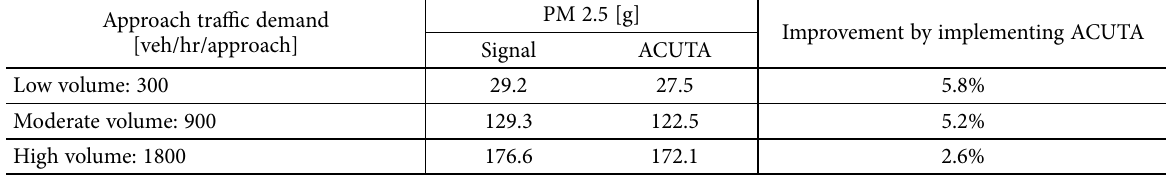
Table 4. Comparison of PM 2.5 emission between multi-tile ACUTA and signal control